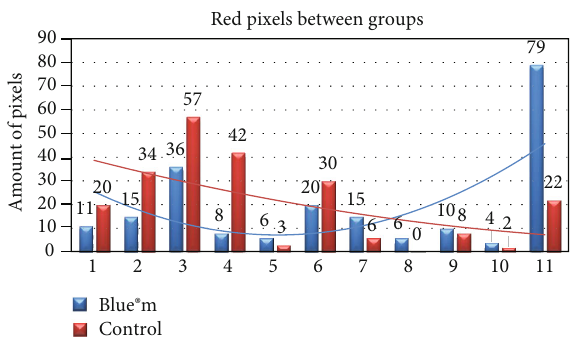
Figure 5: Comparison of the number of red pixels between the control and test sides. ANOVA: two-paired samples. p < 0 : 05